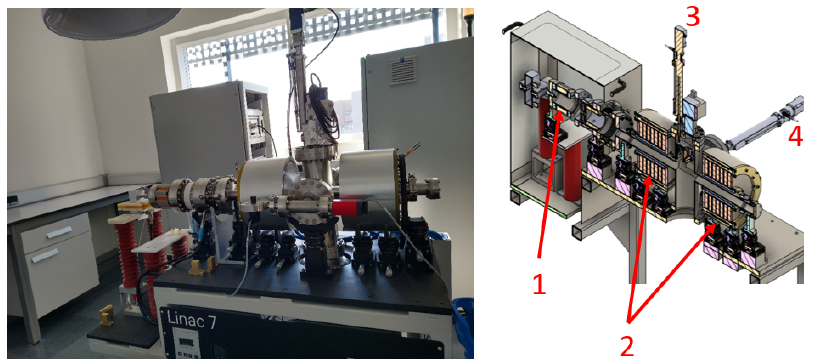
Figure 4. On the ( left ), a photograph of the LEBT as built. On the ( right ), a cross-section of the 3D CAD model, 1 is the ion source, 2 is the solenoids, 3 is the pepperpot and 4 is the Faraday